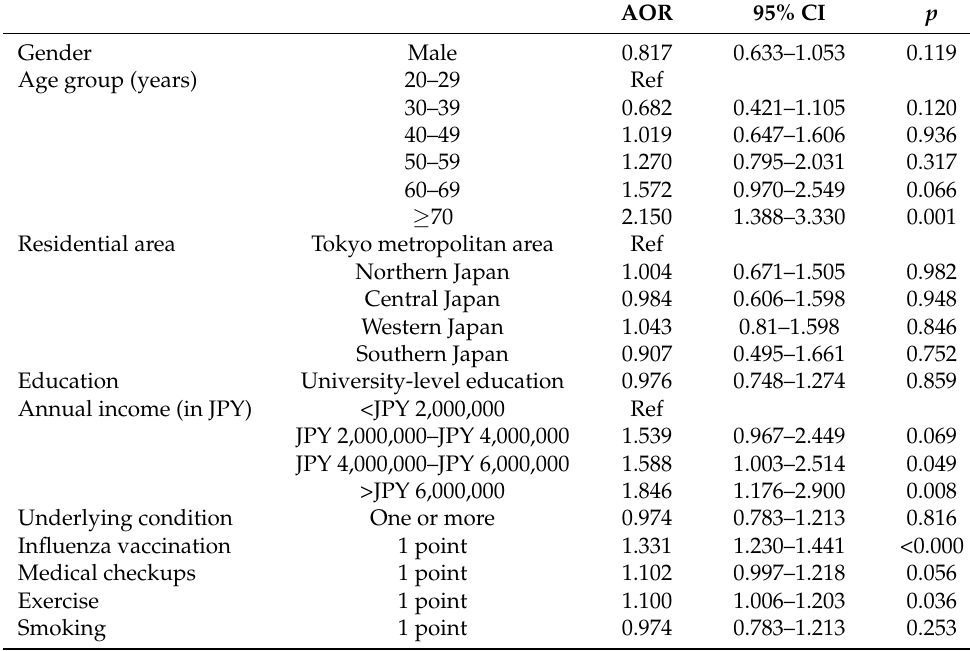
Table 5. Ordinal logistic regression for vaccination attitude in April 2021.